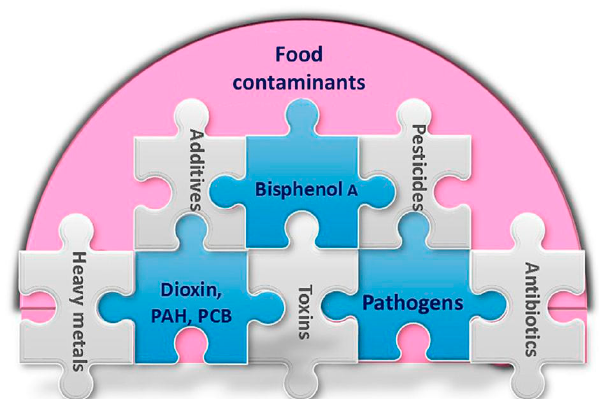
Figure 7. Predominant food contaminants and the target analytes in the food manufacturing industries [67].